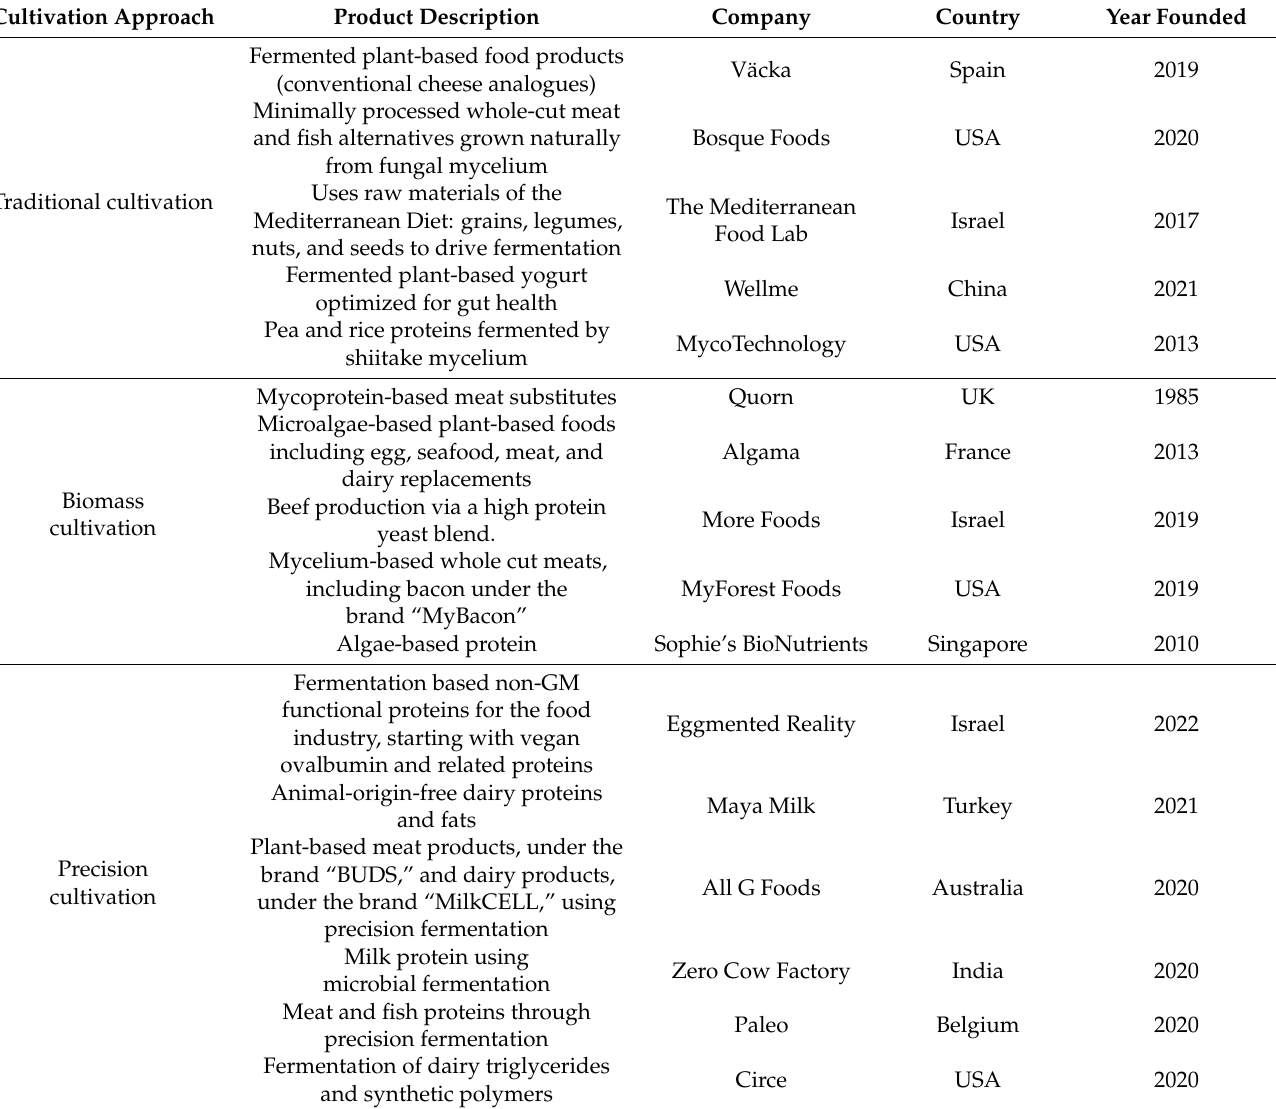
Table 1. Cultivation approaches in the alternative protein industry